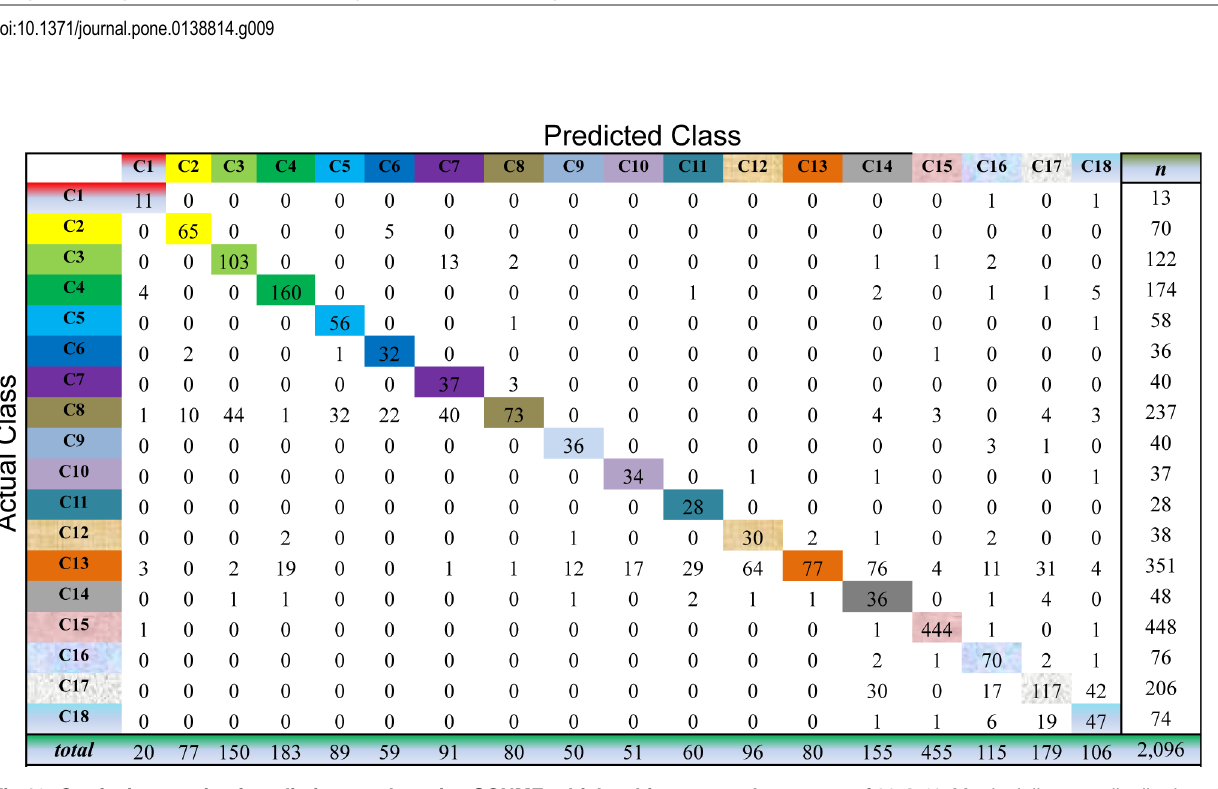
Fig 10. Confusion matrix of prediction results using SCNMF, which achieves a total accuracy of 69.47%. Matrix delineates distribution of actual compared with predicted class membership for multiclass cancer prediction on the Acute Leukemia